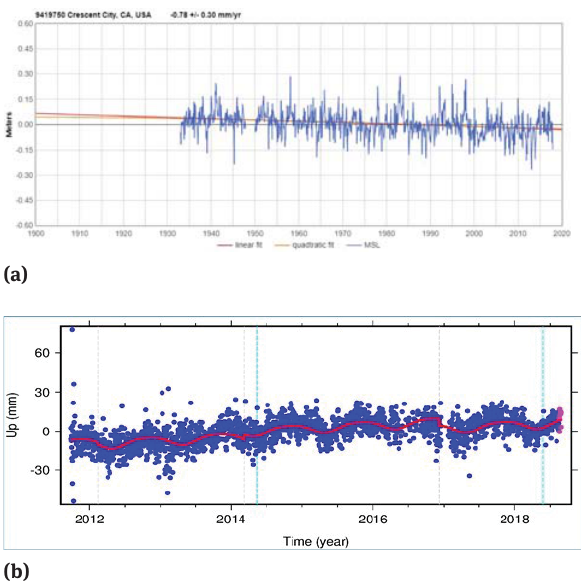
Figure 16: (a) MSL data for Crescent City, CA, USA. Image repro- duced modified after [4]. (b) GNSS time series for CACC. Image reproduced modified after NGL. This GNSS antenna is almost co- located with the tide gauge.